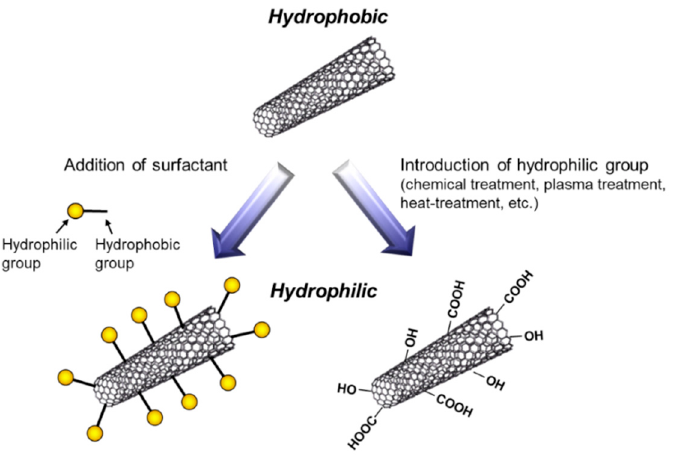
Figure 5. Schematic of hydrophilization of CNTs.